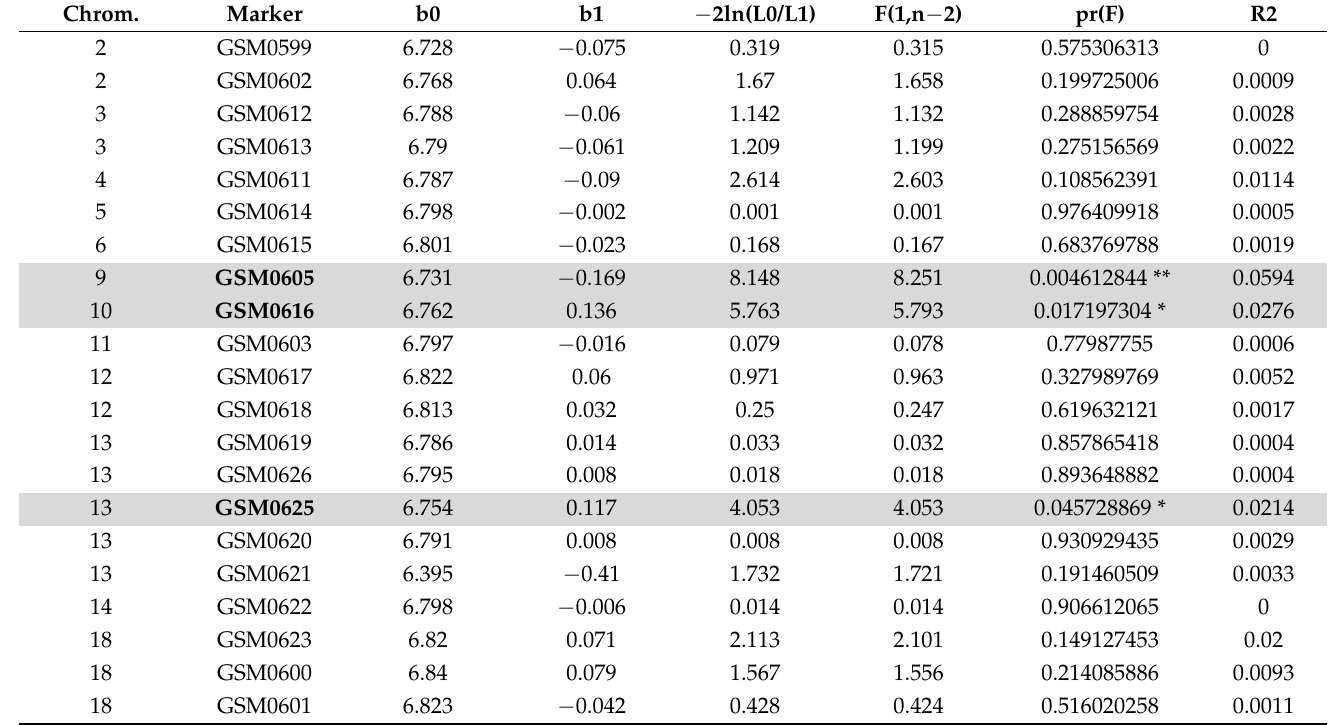
Table 10. Single-factor analysis results using both BLUPs and fixed